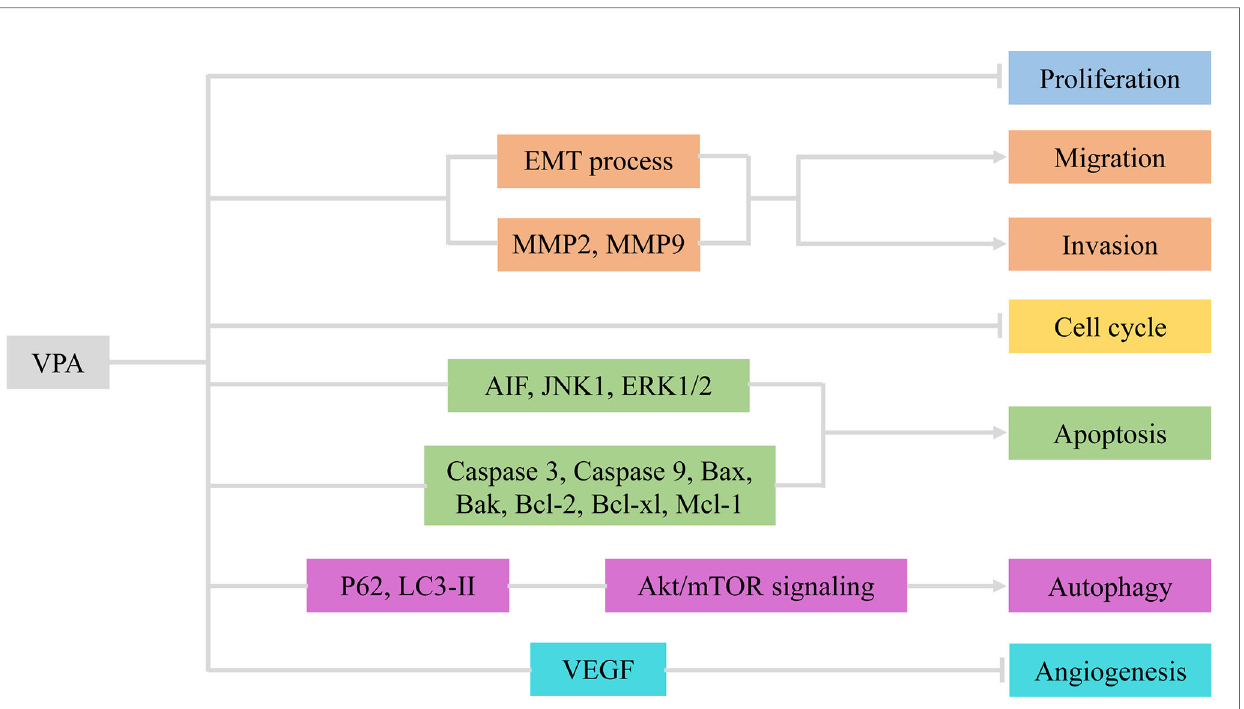
FIGURE 1 | VPA exerted therapeutic effects via involvement with cellular activities of glioma. VPA, valproic acid; EMT, epithelial – mesenchymal transition; MMP2/9, matrix metalloproteinase 2/9; AIF, apoptosis-inducing factor; VEGF, vascular endothelial growth